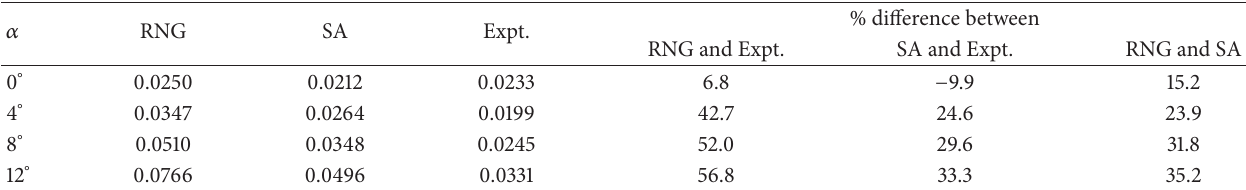
Table 2: Comparison of 𝐶 𝐷 predicted by 𝜅 - 𝜀 RNG and SA models at Re = 2.1 × 10 6 .